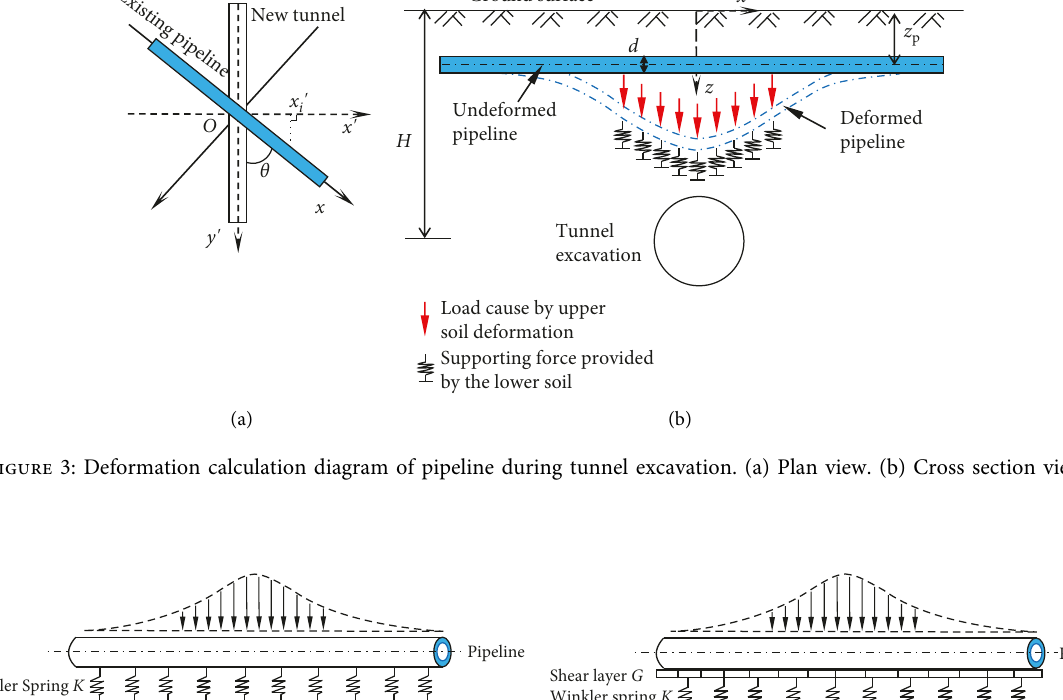
Winkler Spring K